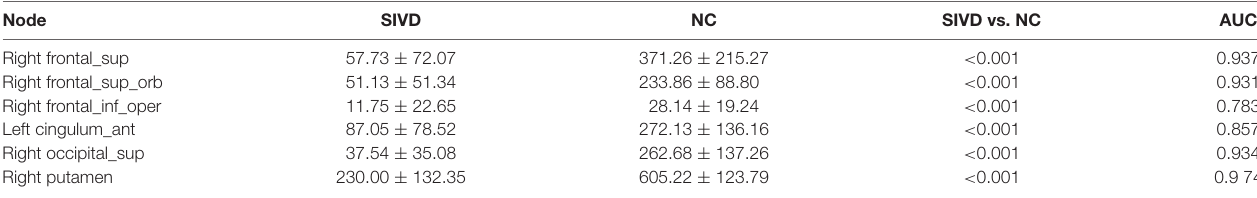
TABLE 4 | The group difference of nodal betweenness centrality in SIVD vs. NC and the diagnostic efficiency of the nodes in the differentiation. Node SIVD NC SIVD vs. NC Right